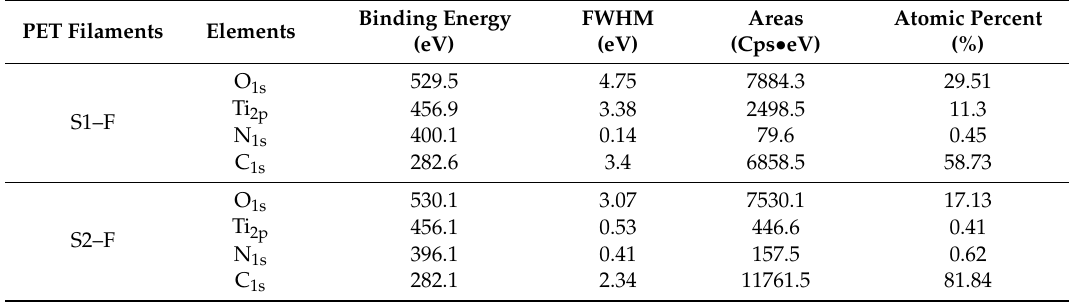
Table 1. The results of X-ray photoelectron spectroscopy (XPS) elemental analysis of the as-modified PET filaments.